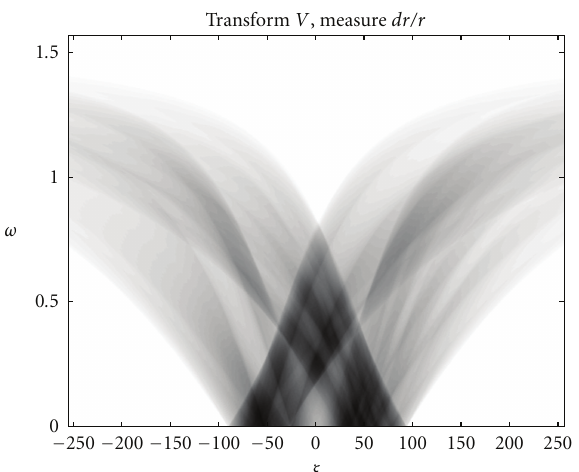
Figure 4: FBP-IM reconstruction of the thyroid phantom with dω = 0 . 005 rad.